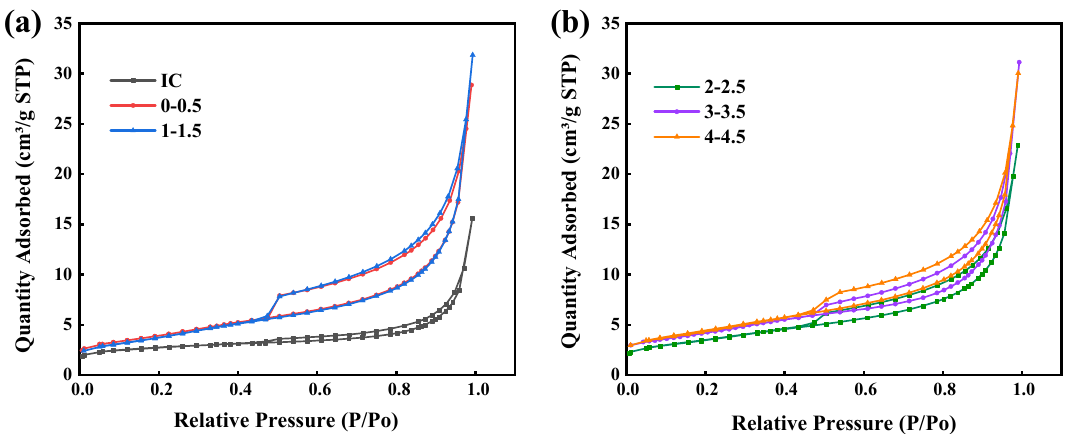
Figure 7. The radial coke adsorption and desorption curves of IC and TC. ( a ) IC, TC: 0–0.5 and 1–1.5; ( b ) TC: 2–2.5, 3–3.5 and 4–4.5.